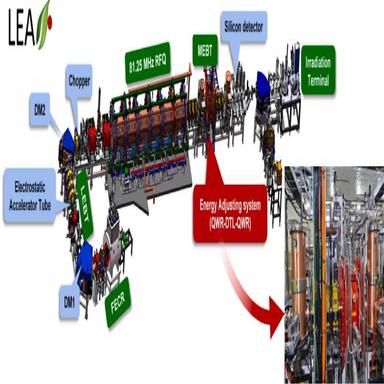
Layout of the upgraded LEAF platform.